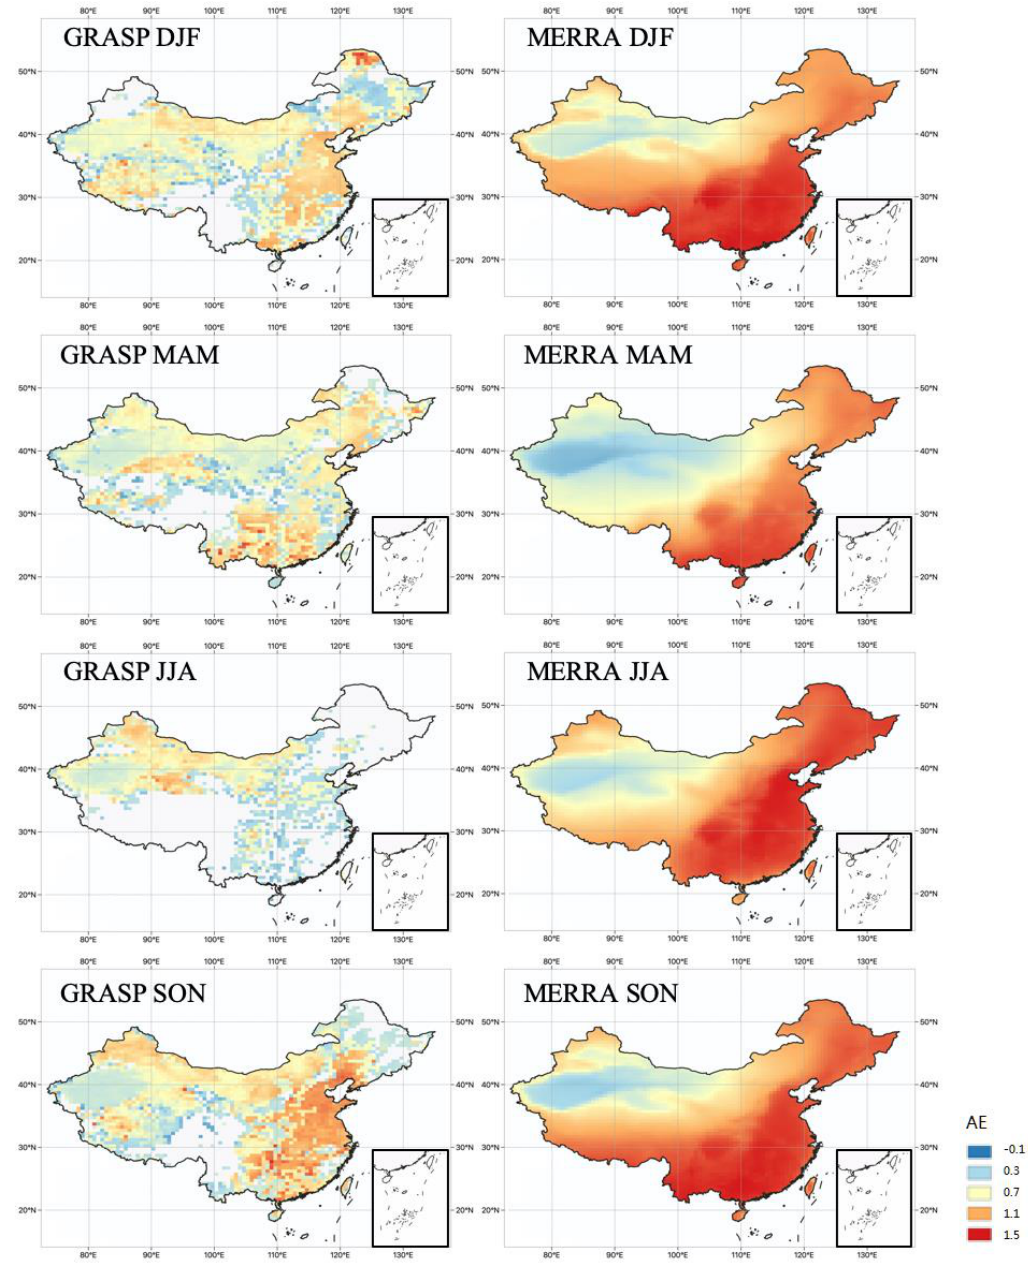
Figure 11. Same as Figure 9, but for AE.